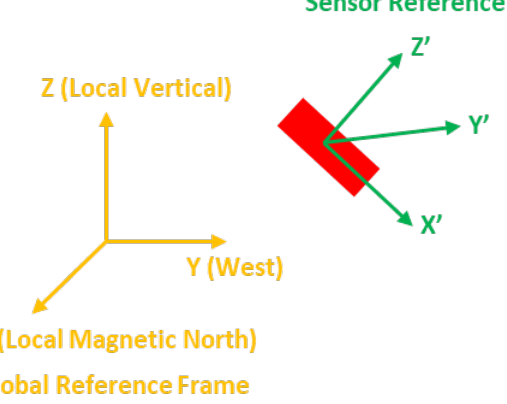
Figure 1. Sensor and global reference frames.